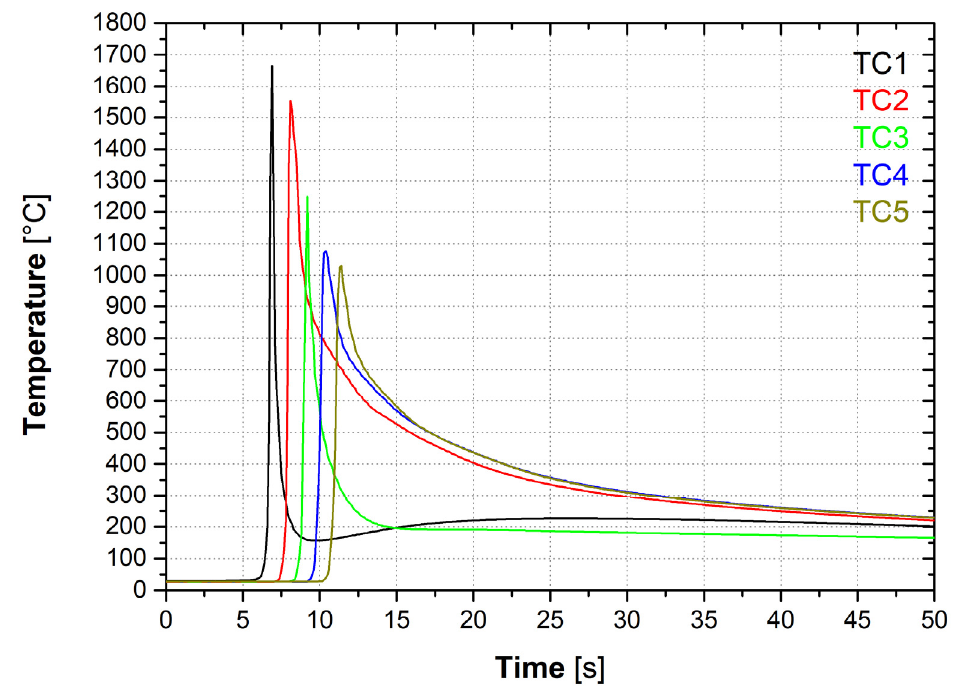
Figure 8. Temperature cycles measured in Weld_8_A.